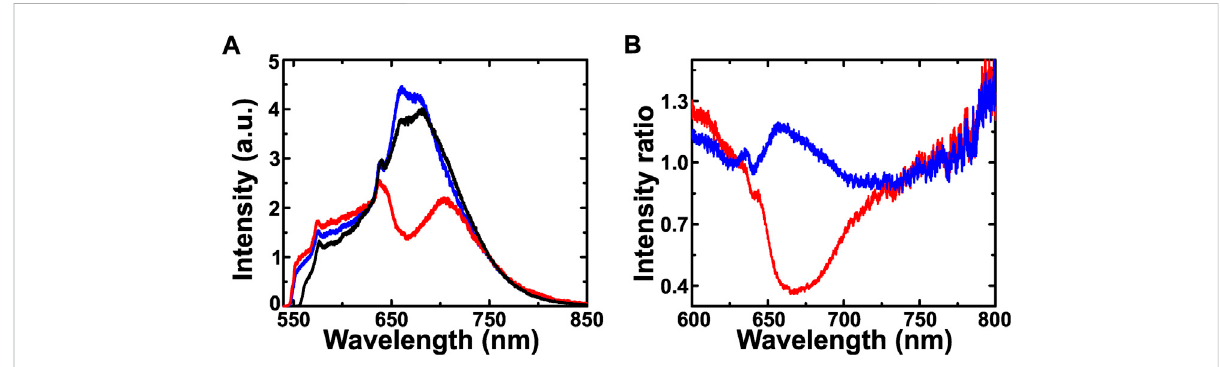
FIGURE 4 (A) The emission spectra of the reference sample (black) showing characteristic ZPLs of NV center charge states (NV 0 and NV − ) at 576 and 639 nmalongwithabroadPSBemission.TheemissionspectrameasuredfromsampleBintherear-side(red)andfront-side(blue)geometry. (B) The intensity ratio of the emission from sample B in the rear-side (red) and front-side (blue) geometry with respect to the emission from the reference sample.